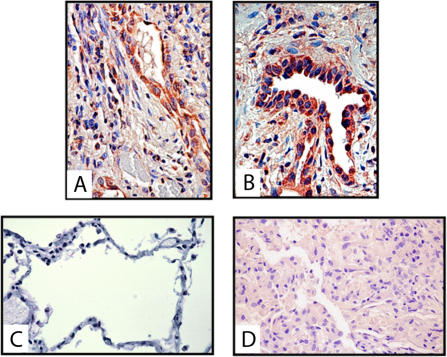
Localization of Osteopontin in IPF LungsImmunoreactive protein was revealed with AEC, and samples were counterstained with hematoxylin. Two representative IPF lung samples exhibited strong epithelial staining (original magnification, 40×) (A,B). Control lung showed no staining (C). Negative control section from IPF lung in which the primary antibody was replaced with nonimmune serum also showed no staining (40×) (D).